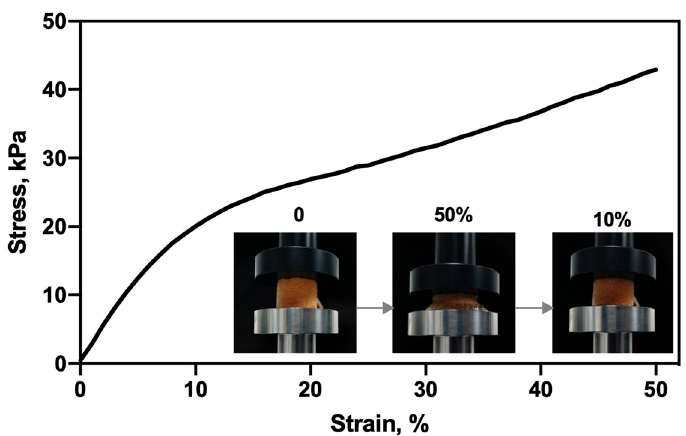
Figure 5. Compressive stress–strain curve of CHT/PCD sponge after immersion in PBS for 2 h, tested at room temperature. Representative images of sponge during the compression test. On the left, the scaffold at the beginning of the test; in the middle, scaffold compressed at 50% strain; on the right, scaffold recovered their shape at the end of the test (10% strain). The curve corresponds to the average values of three repetitions ( n = 3).